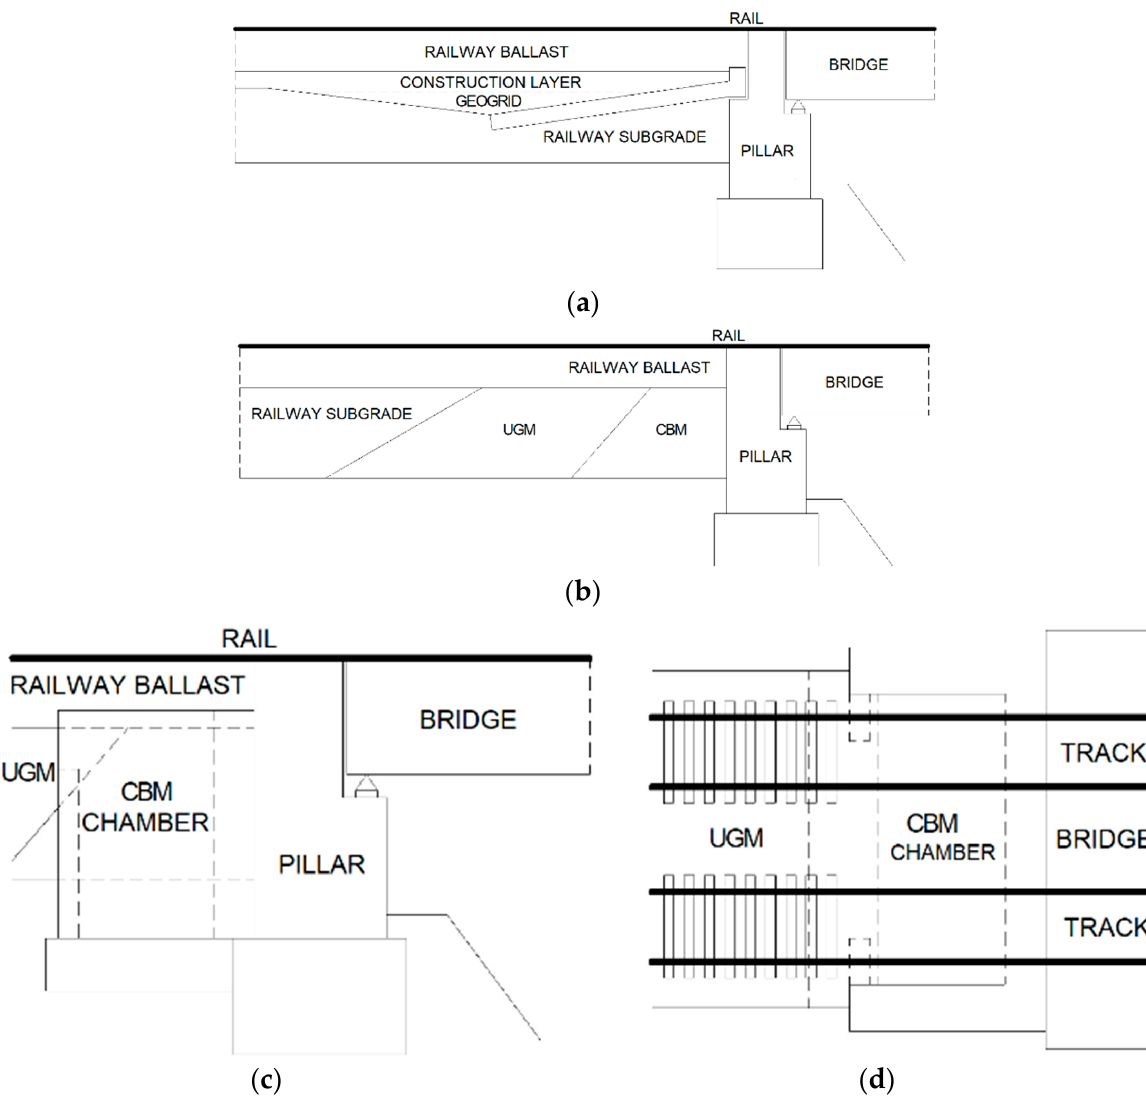
Figure 4. Design of transition zones as ballasted track and bridge: ( a ) Reinforced concrete slab; ( b ) CBM and UGM material; with CBM chamber: ( c ) Section view and ( d ) Plan view.